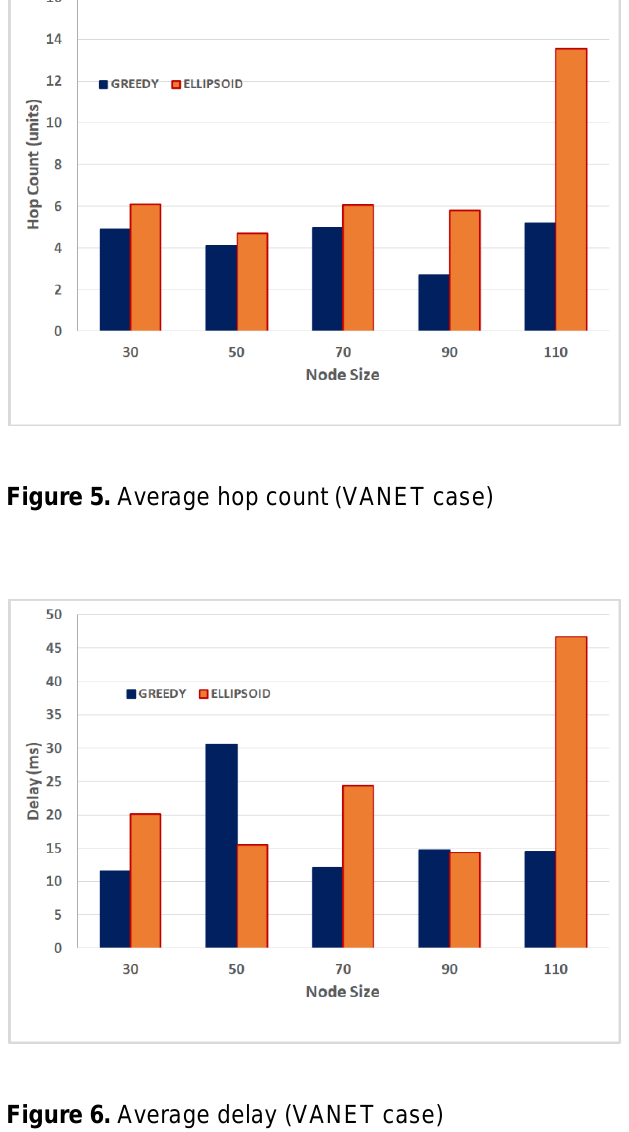
Figure 6. Average delay (VANET case)